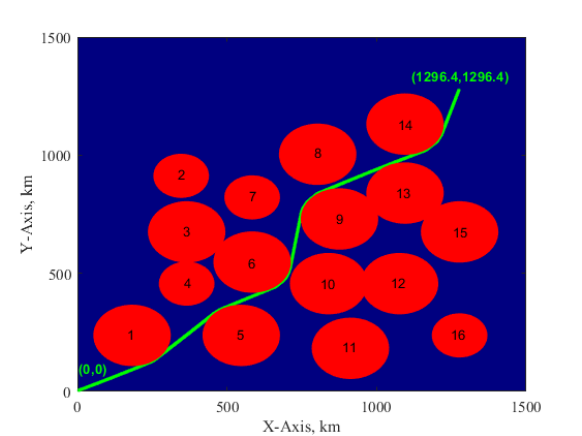
Figure 4. Shortest path by avoiding 16 radars without regard for flight mechanics for scenario 1